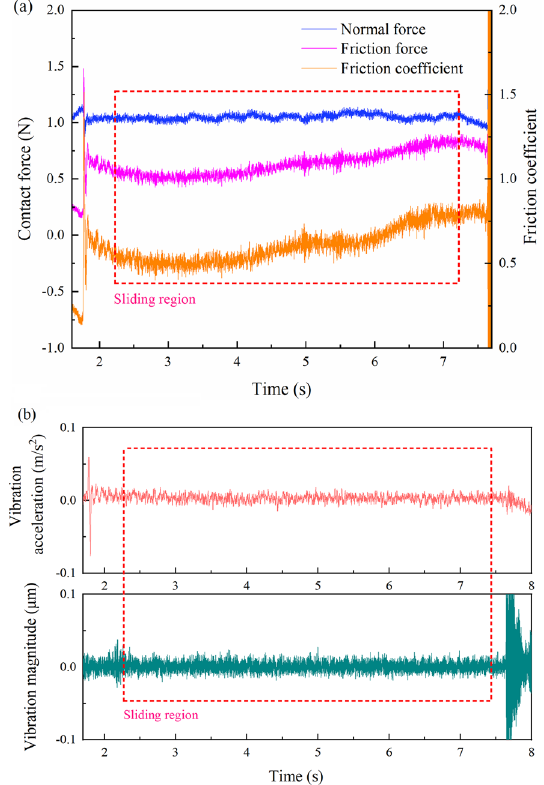
Figure 8 Analysis parameters for passive sliding against PTFE#3, including ( a ) contact force and friction coefficient, ( b ) vibration acceleration and vibration